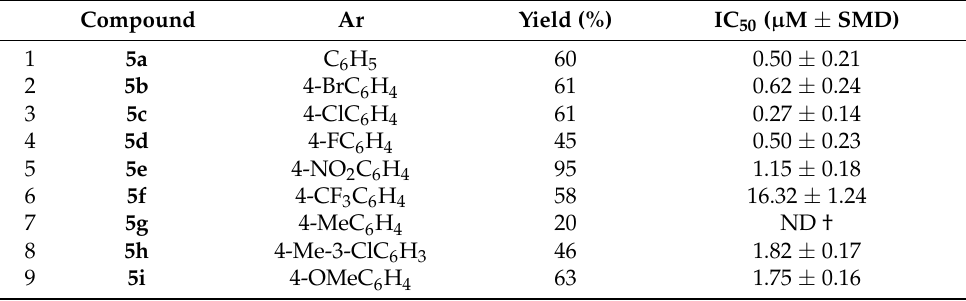
Figure 3. Anti-proliferative activity of thiazolidines 5a – f and 5h – l ; ( A – C ) cell viability of MCF7 cell incubated with thiazolidine and tested by MTT assay after 96 h. ( D ) calculated IC 50 based on non-linear data obtained from the cell viability study. Table 1. The synthesized thiazolidines 5a – l and their IC 50 against an MCF7 cell line.